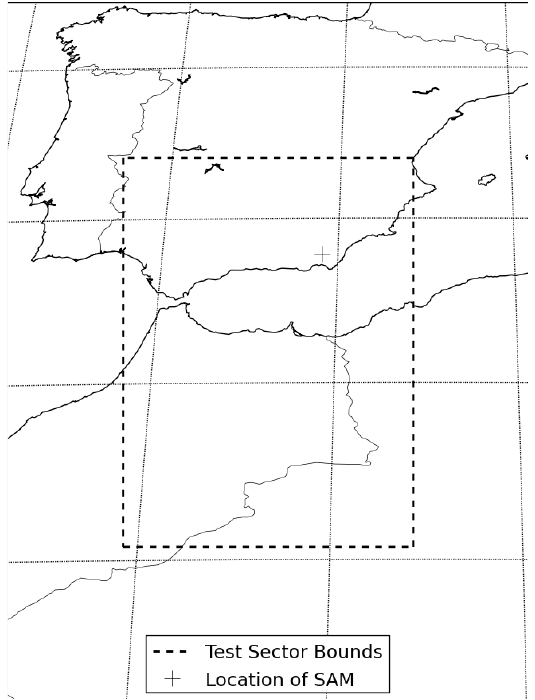
Fig. 5. Map covering the test sector. SEVIRI pixels are evaluated inside the sector (only over land). The cross marks the location of the SAM instrument at the Plataforma Solar de Almería (Sect. 3.3).